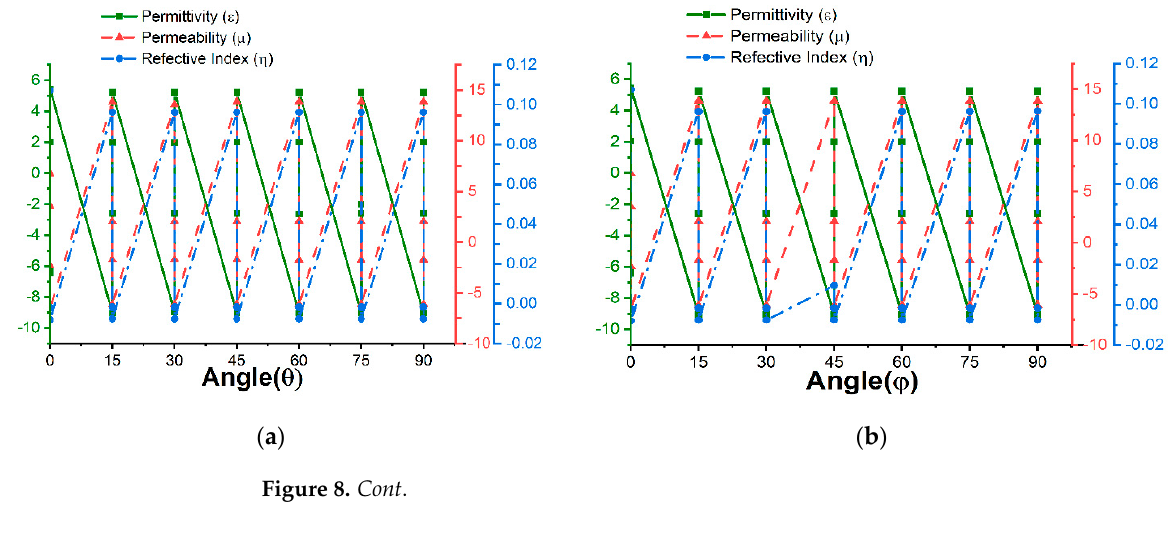
Figure 7. FR-4 permittivity, permeability, and reflective index with respect to polarization angle θ and φ for ( a , b ) S 11 and ( c , d ) S 21 .